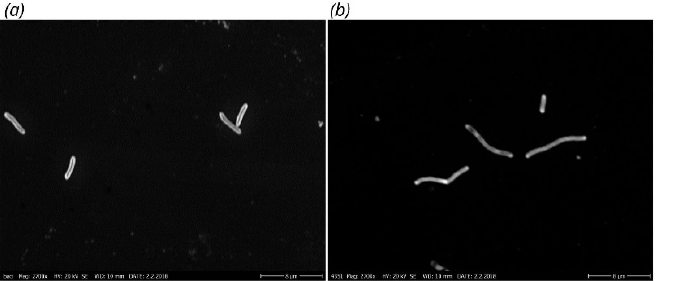
Figure 3. Scanning electron microscopic images of S. sonnei cells, showing ( a ) normal cell morphology for Shigella sonnei 4303 and ( b ) chains of 2–5 cells with septa for Shigella sonnei 4351. The magnification was 2700×.